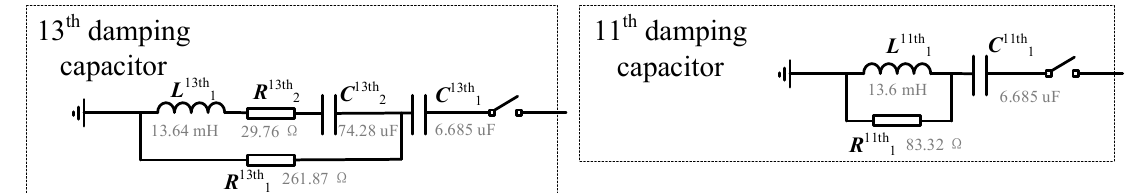
Figure 8. 11th and 13th damping capacitors structure of Cigre Benchmark model.